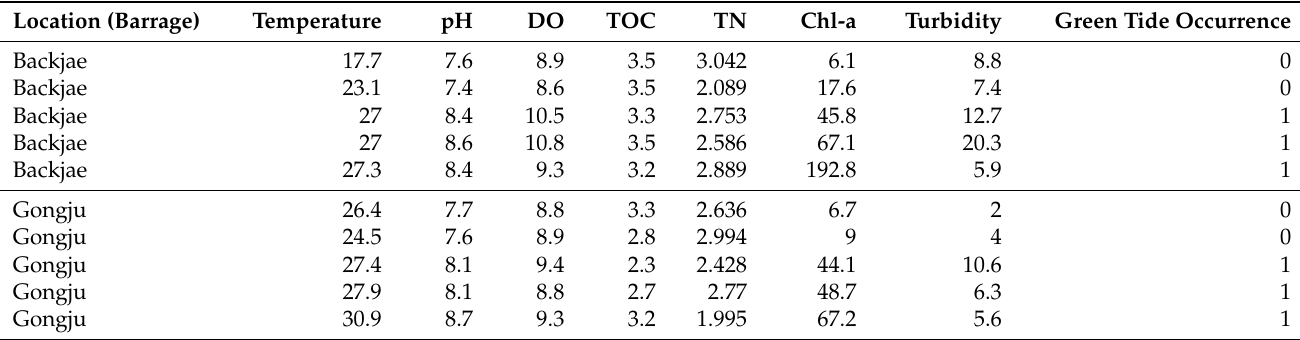
Table 2. Water quality monitoring data sample of Keum River with 7 indicators. The sample data are based on the data observed around Backjae barrage and Gongju barrage.